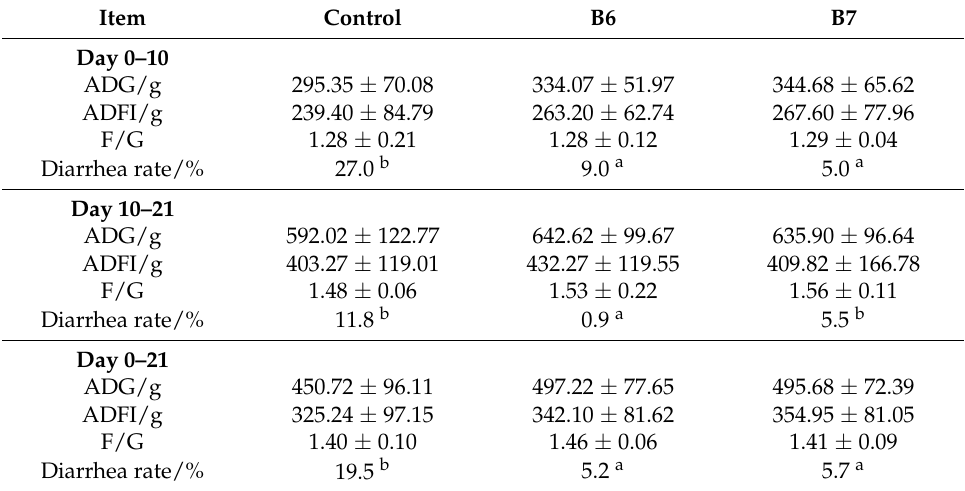
Table 1. Effects of B. coagulans on growth performance of weaned piglets.